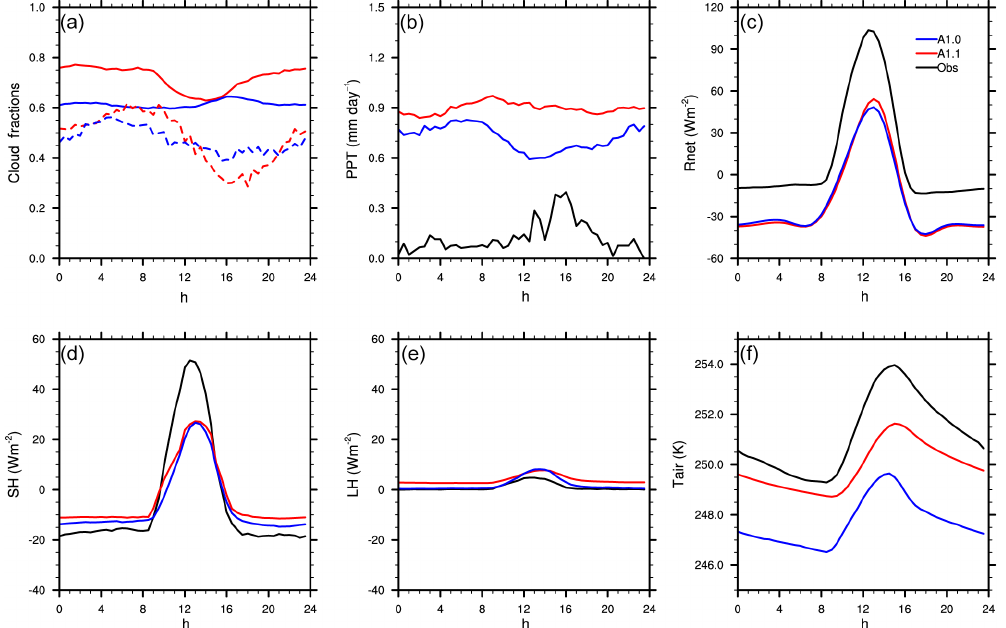
Figure 11. January diurnal cycles of (a) total cloud fraction (solid) and (1-year average only) very low cloud fraction (dash), (b) precipi- tation (PPT, mmday − 1 ), (c) net radiation (Rnet, Wm − 2 ), (d) sensible heat (SH, Wm − 2 ), (e) latent heat (LH, Wm − 2 ), and (f) screen/air temperature (Tair, K) for Boreas (55.88 ◦ N, − 98.48 ◦ E). Observations in black, ACCESS1.0 in blue, and ACCESS1.1 in